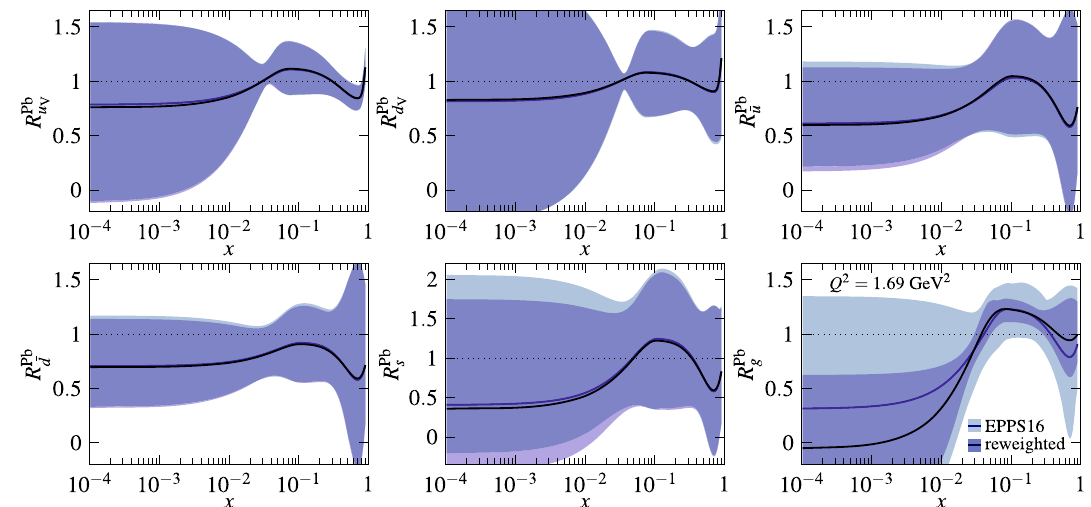
Fig. 11 The impact of reweighting the EPPS16 nPDFs with the data on the nuclear modification ratio of the dijet spectra. The original and reweighted EPPS16 nuclear modifications for the lead nucleus are pre- Fig. 12 The EPPS16 gluon nuclear modifications in Pb at the scales Q 2 = 10 GeV 2 and Q 2 = 10 4 GeV 2 before and after reweighting with the dijet